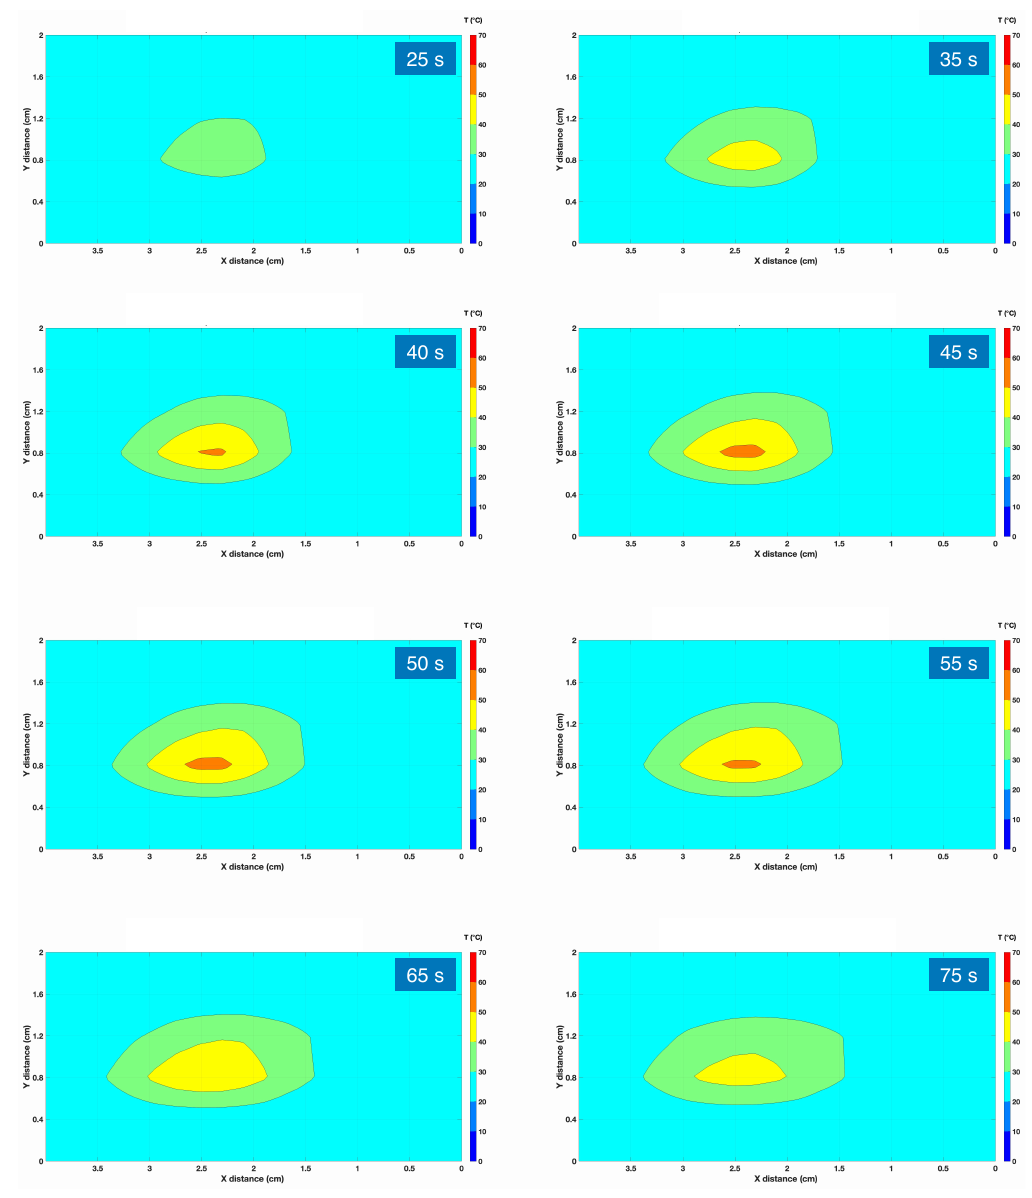
Figure 8. Thermal map recorded for an RFA experiment, using AuNP with a density of 4 mg/mL. The chart reports the data recorded on the xy plane (x = direction parallel to the RFA applicator and to the sensing fibers). The colorimetric map reported the isothermal curves, with 10 ◦ C separation between each layer. Eight different maps are reported, during the heating phase (with times 25, 35, 40, 45, and 50 s from the RF generator power on), and during the cooling phase when the RF power is discontinued (55, 65, and 75 s elapsed time). The horizontal lines on each chart report the position of the six